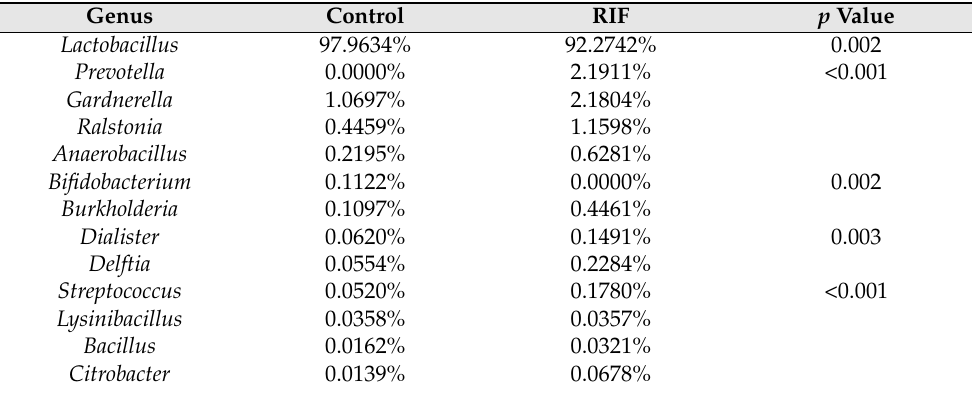
Table 2. Taxonomic diversity of the bacterial community at the genera level in the control and RIF cohorts. Genus Control RIF p